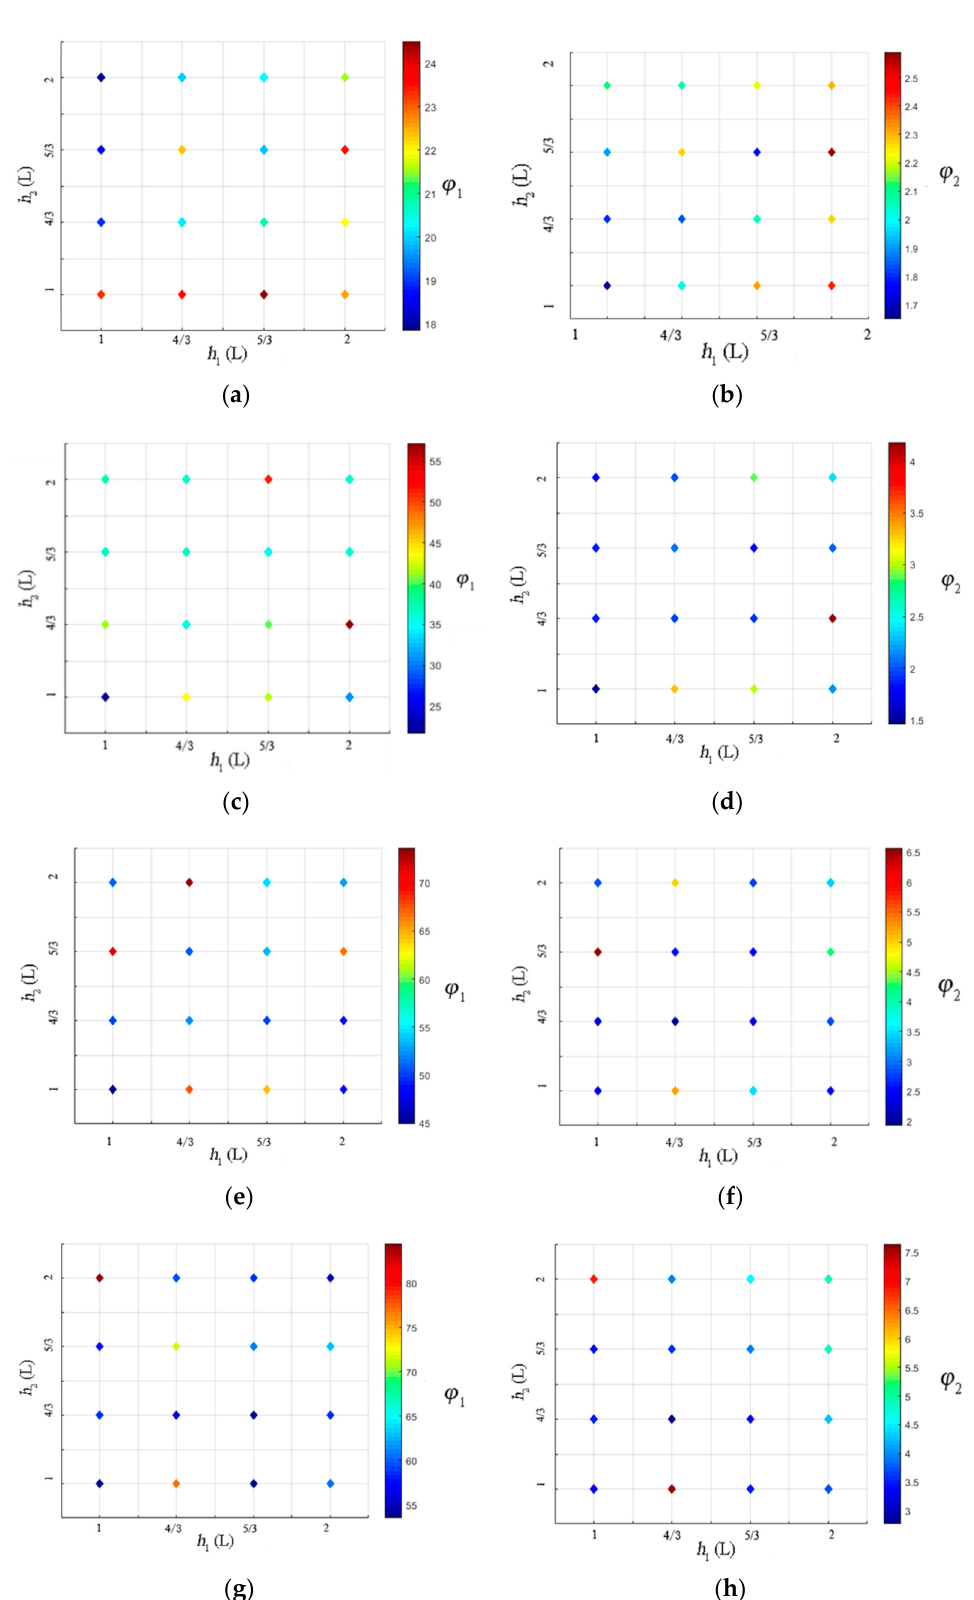
Figure 8. Efficiency indices of four combined URs with different AIs and IRs. Note: ( a ): Upwelling efficiency index at 0°; ( b ): Wake efficiency index at 0°; ( c ): Upwelling efficiency index at 15°; ( d ): Wake efficiency index at 15°; ( e ): Upwelling efficiency index at 30°; ( f ): Wake efficiency index at 30°; ( g ): Upwelling efficiency index at 45°; ( h ): Wake efficiency index at 45°. Table 1. The optimal combination of efficiency indices.